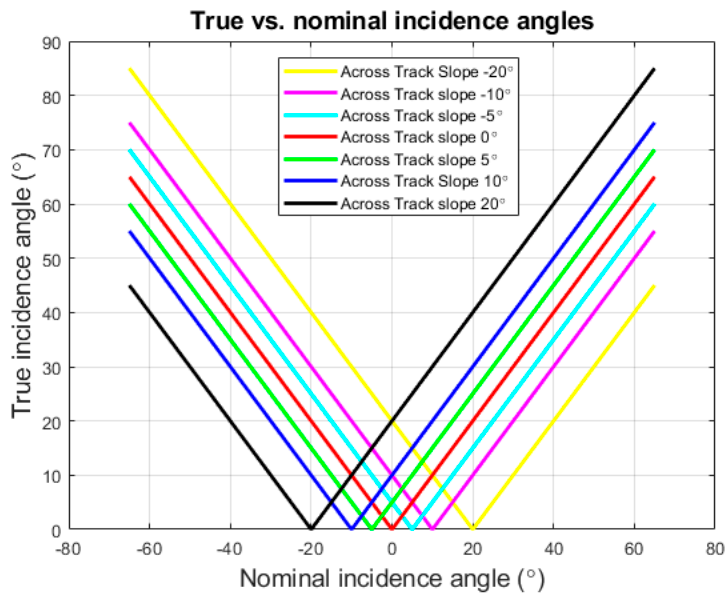
Figure 9. Effect of the across-track slope on the seafloor incidence angle, computed for various angles, relative to nadir. Along-track slope is assumed as 0°.